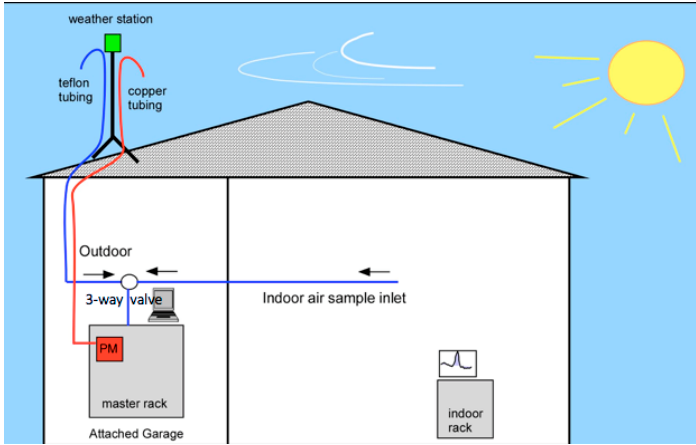
Figure 2. Locations of indoor and master racks.